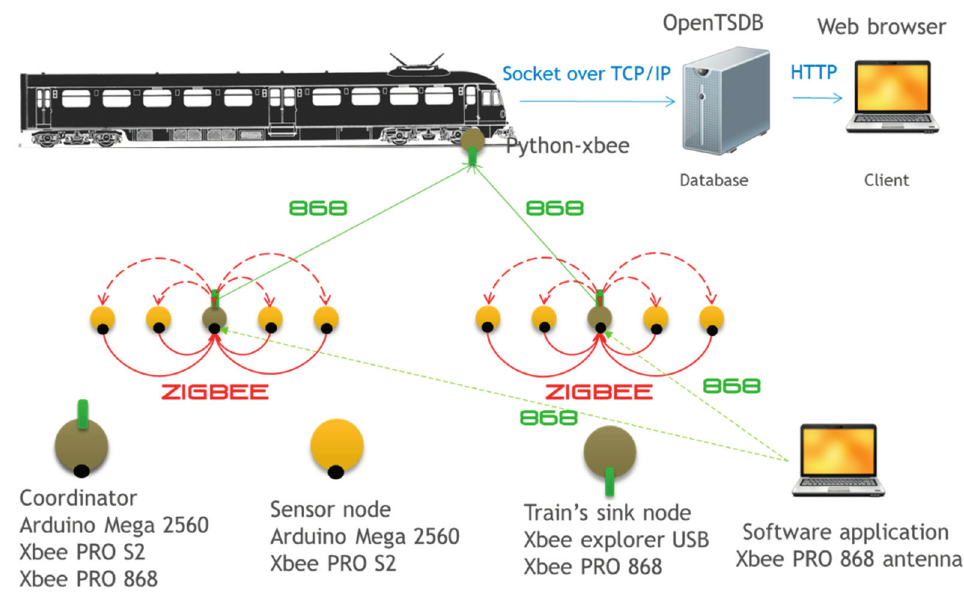
Figure 16. Complete system communication